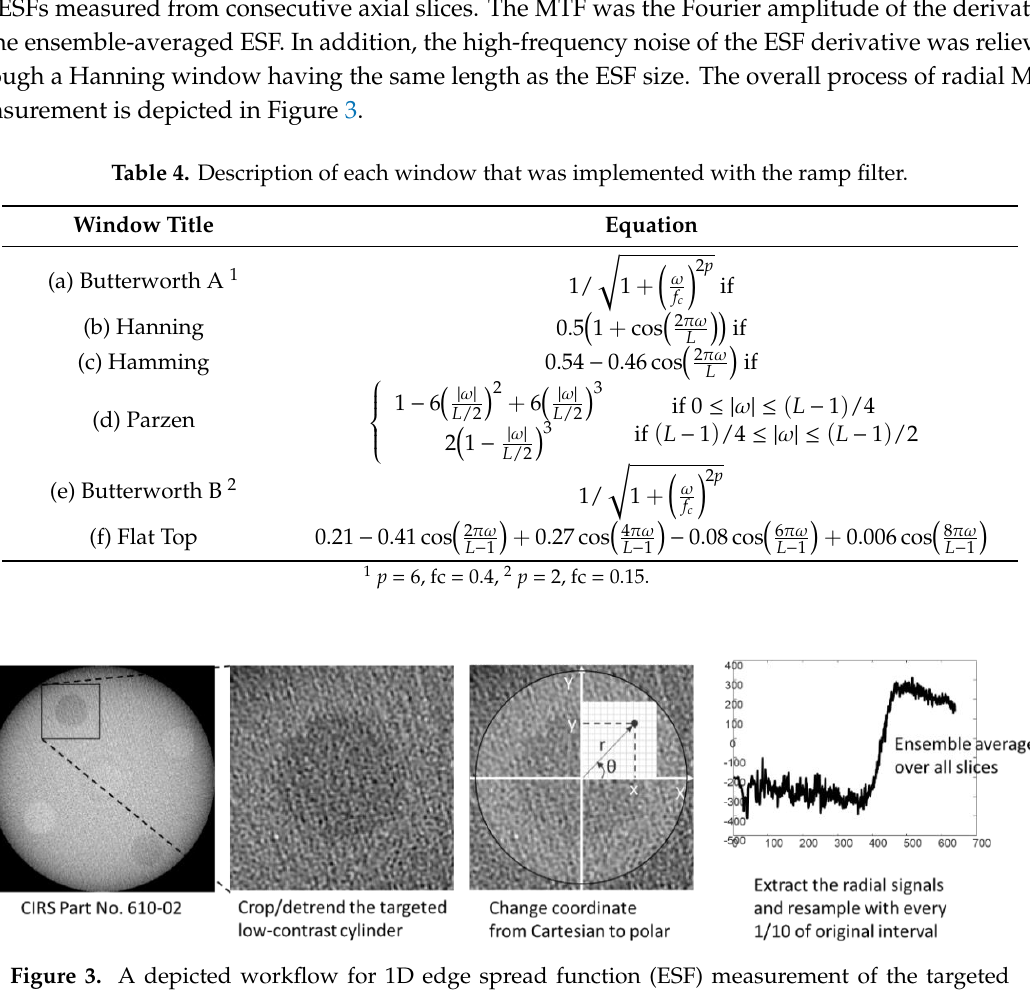
Figure 3. A depicted workflow for 1D edge spread function (ESF) measurement of the targeted low- contrast